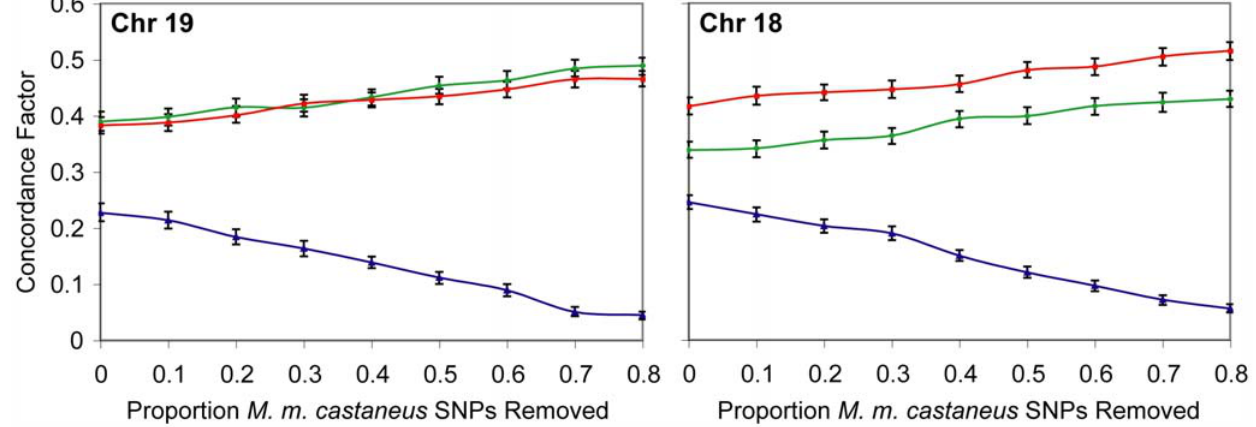
Figure 5. Simulated ascertainment bias against M.m.castaneus . Varying proportions of M. m. castaneus specific SNPs were removed from chromosomes 18 and 19 to simulate increased ascertainment bias against this taxon. The difference in concordance factors between M. m. musculus / M. m. castaneus and M. m. castaneus / M. m. domesticus do not significantly differ at all levels of artificial bias. This indicates that recovery of a M. m. musculus/M. m. castaneus primary phylogenetic history is robust to increased ascertainment bias. Colors correspond to the three topologies. Error bars are 95% confidence intervals.